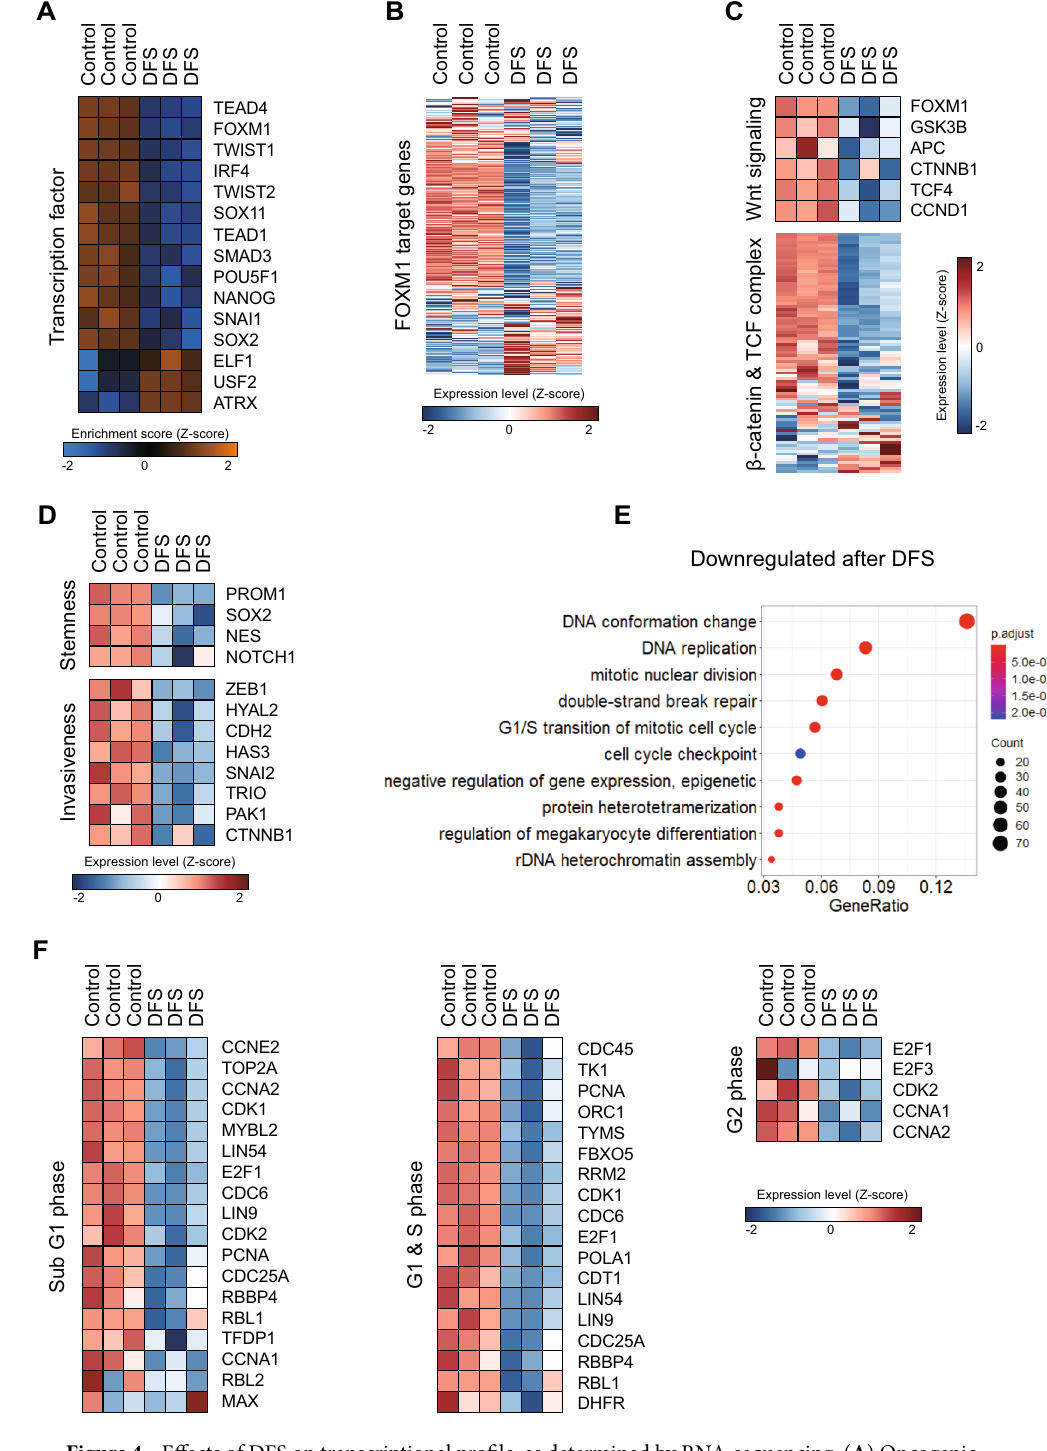
Figure 4. Effects of DFS on transcriptional profile, as determined by RNA-sequencing. ( A ) Oncogenic and tumor suppressor transcription factors measured by single gene set enrichment analysis (ssGSEA). ( B ) Expression of target genes of FOXM1 evaluated by RNA-sequencing. ( C) Expression of Wnt signaling genes and β-catenin/TCF complex related genes evaluated by RNA-sequencing. ( D ) Heat map showing levels of expression of stemness- and invasiveness-associated genes. ( E ) Set of genes downregulated after treatment with DFS for 72 h. ( F ) Heat map showing levels of expression of cell cycle-related